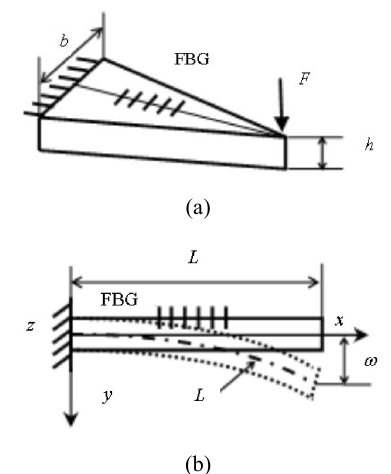
Fig. 1 Schematic of the FBG vibration sensor structure and beam bending with force: (a) sensor structure and (b) schematic of beam bending with